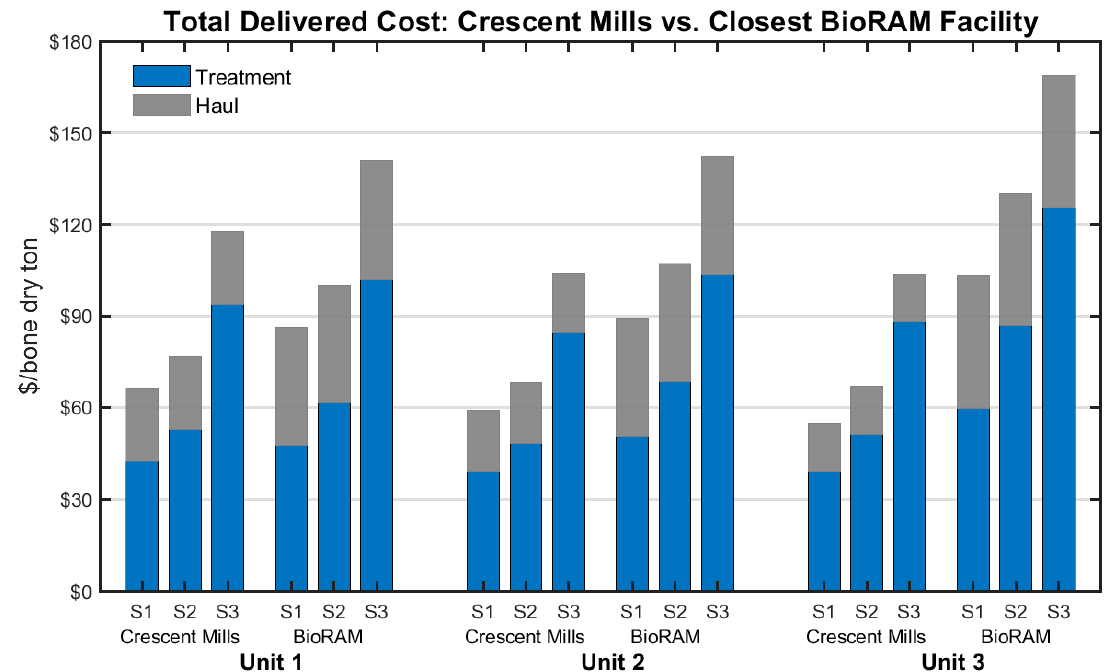
Figure 6. Changes in total costs of delivered biomass across scenarios and harvest units owing to biomass destination change from Crescent Mills to closest BiomRAM facility. S1, S2, and S3 represent Integrated Harvesting, Fuels Reduction Only (Mechanized), and Fuels Reduction Only (Hand Thin), respectively.